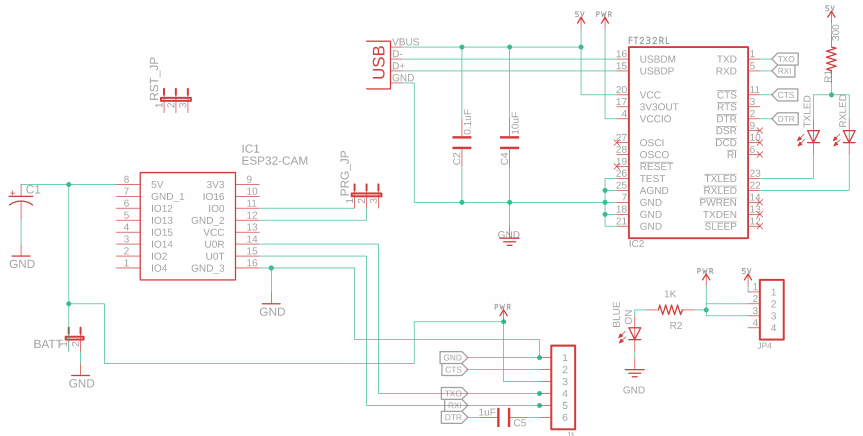
Figure 9. Schematic of the camera